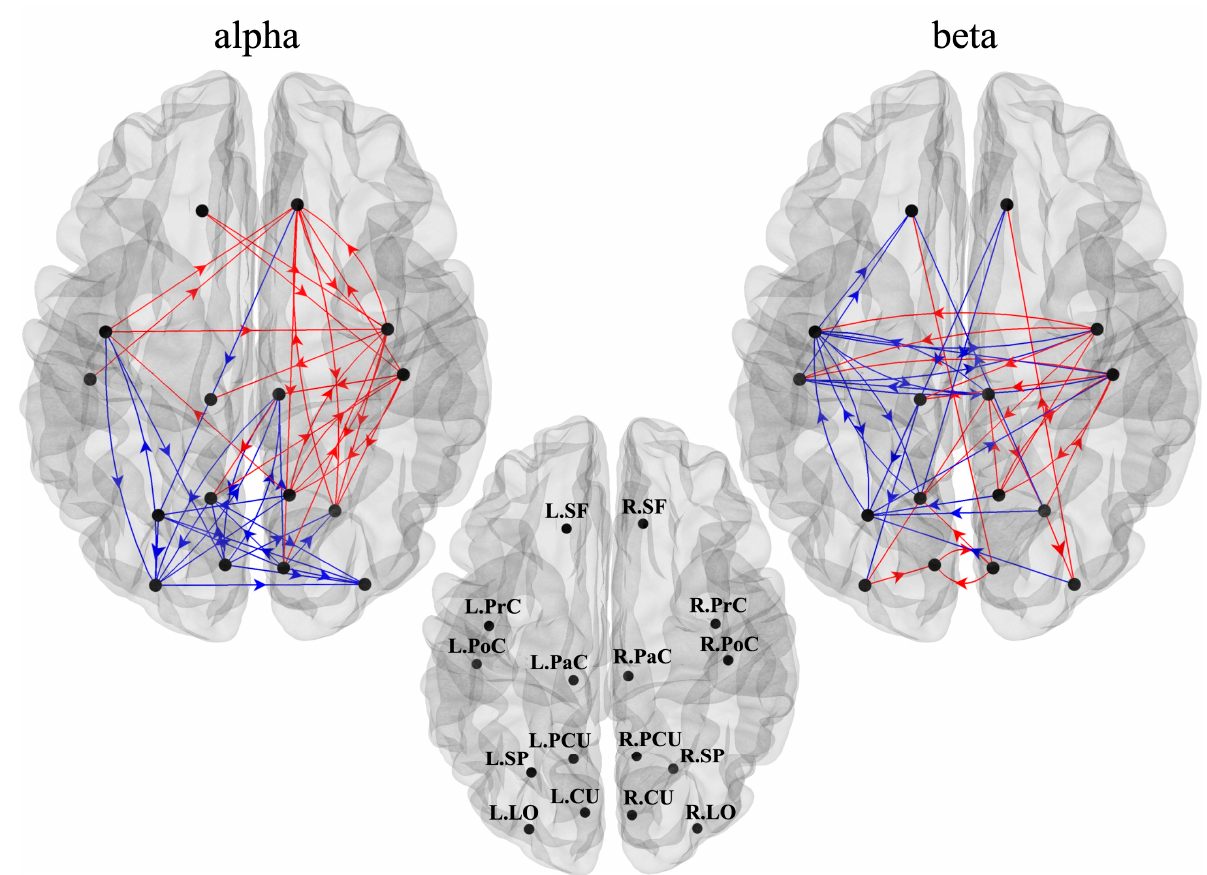
Figure 5. Directed connections between ROIs—as measured by the spectral Granger causality—that resulted significantly higher (in red) or lower (in blue) during reaching movement preparation compared to rest, in alpha ( left ) and beta ( right ) bands. To improve readability, ROI labels are displayed on the cortex in the middle panel, separately from the other panels.